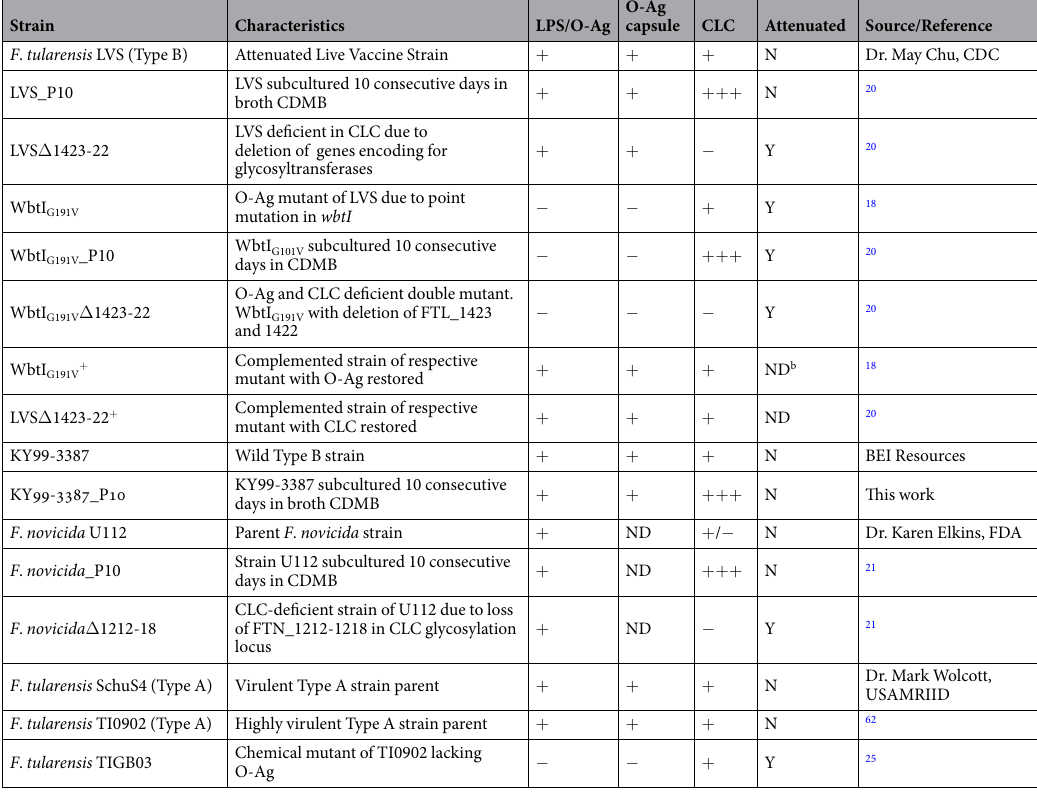
Table 1. Strains used in this study. ( + , present; +++ , enhanced; − , not present). a Not determined.